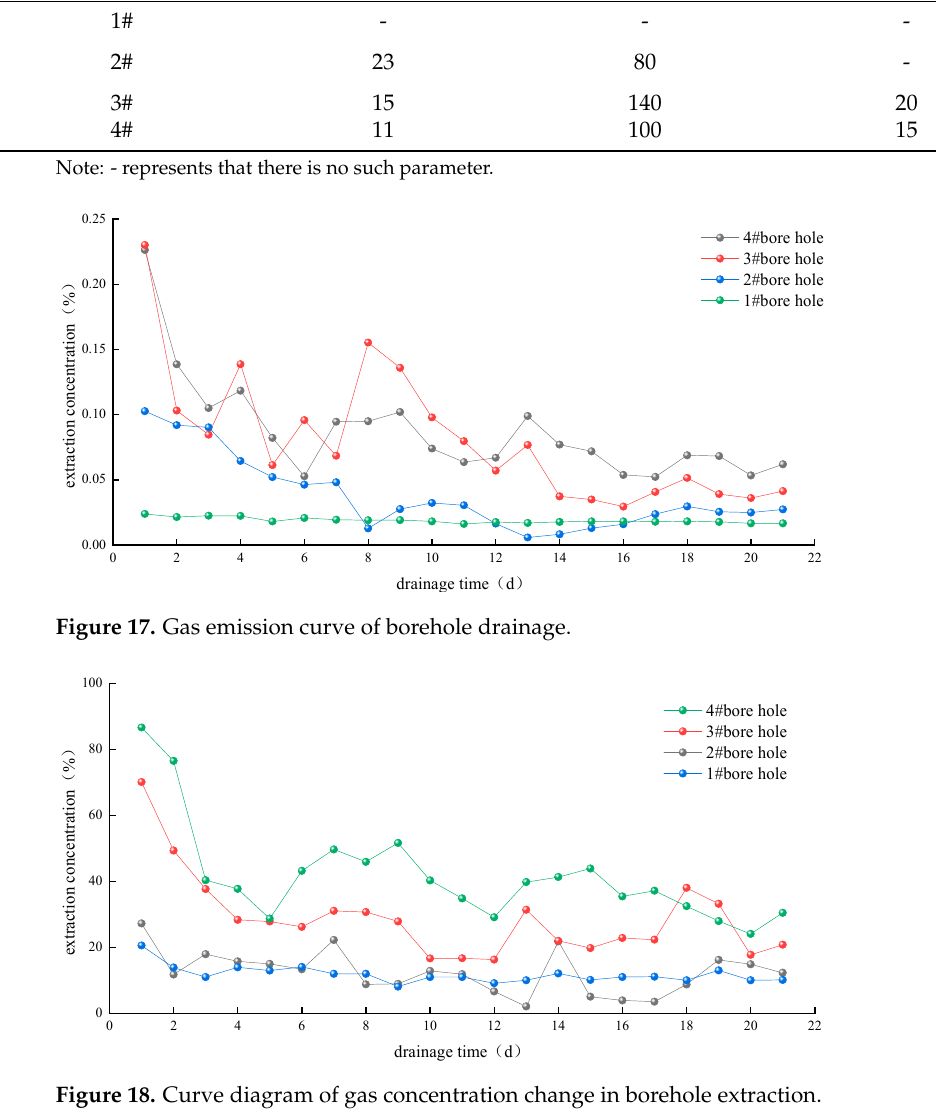
Figure 18. Curve diagram of gas concentration change in borehole extraction.